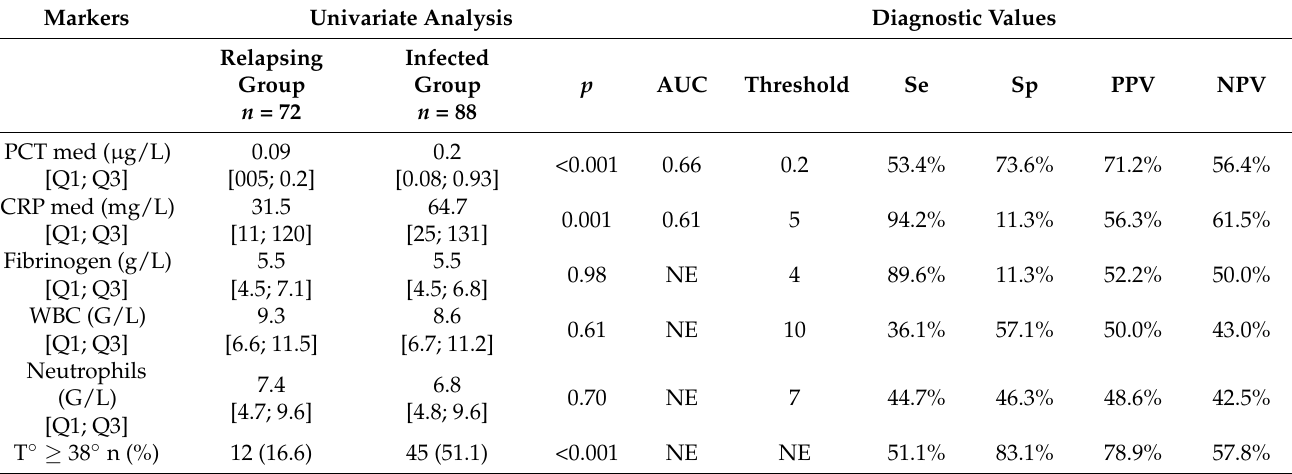
Table 2. Comparison in univariate analysis of clinicobiological markers at relapse or infection and their performance for the diagnosis of infection in 74 patients with